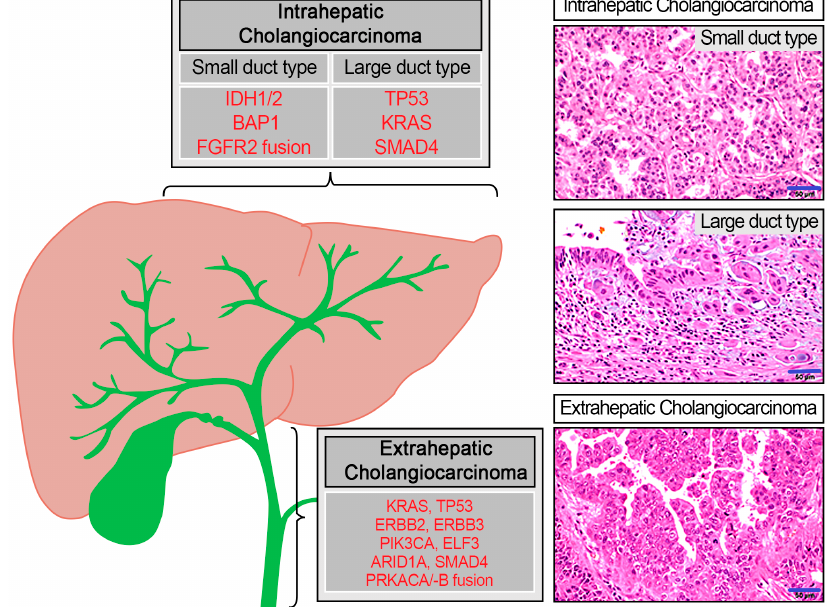
Figure 1. Known driver genes based on subtypes of cholangiocarcinoma and histologic characteristics (Scale bar = 50 µm)